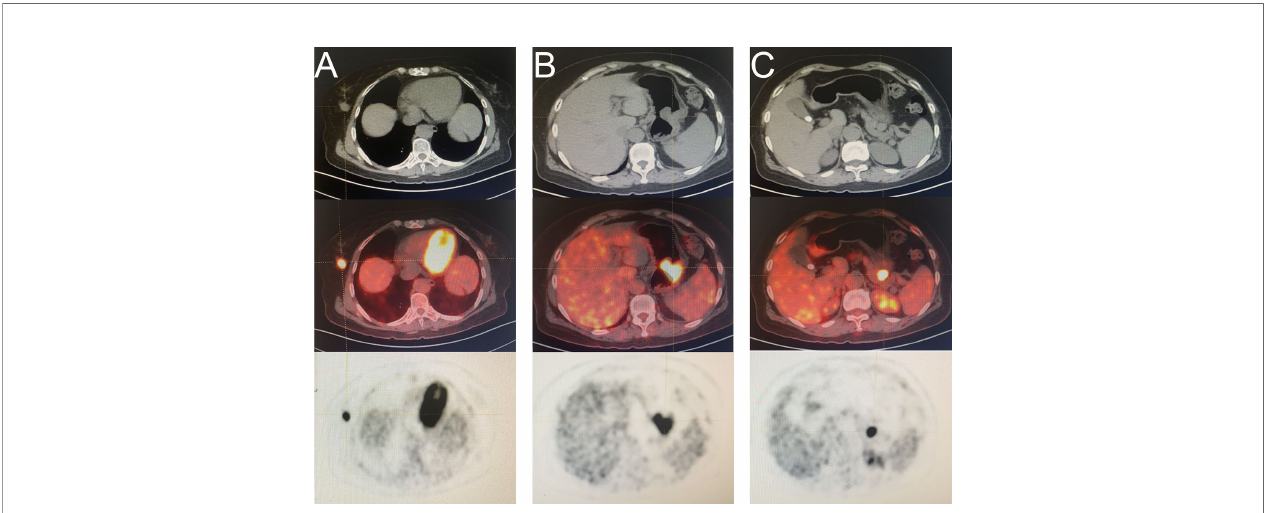
FIGURE 1 | A F18- fl uorodeoxyglucose (FDG) positron emission tomography computed tomography (PET-CT) scan was conducted. (A) mass in right breast (B) mass in the greater curvature of the stomach (C) mass in the space between the stomach and